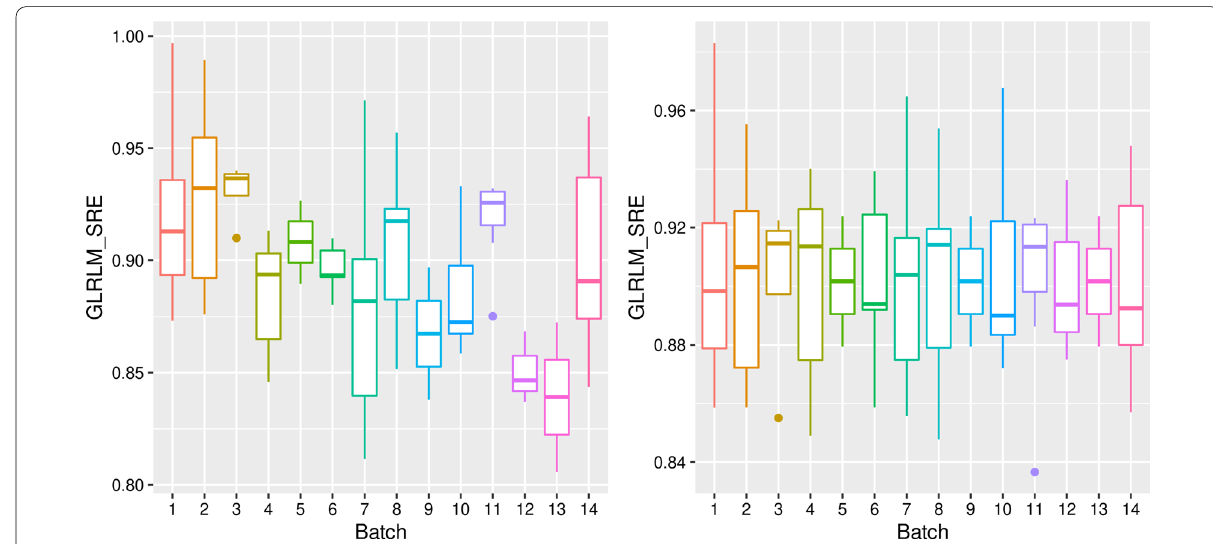
Fig. 1 An example of feature harmonization for the GLRLM SRE feature. On the left is the box-plot for the feature distribution across batches (defined as protocols) before ComBat harmonization, and on the right is the Box-plot after the